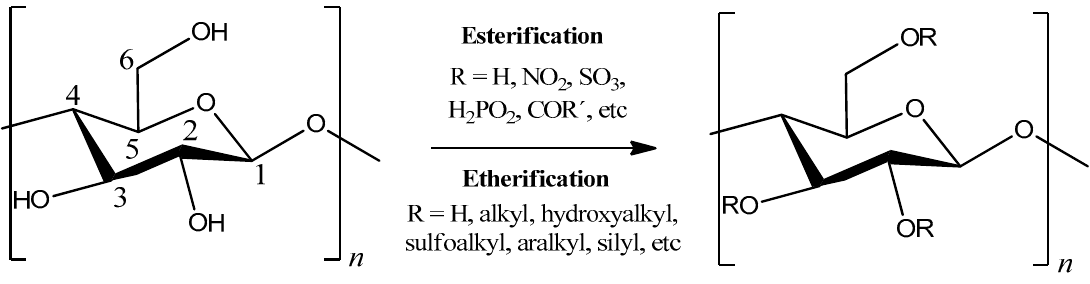
Figure 3. Synthesis of cellulose esters and ethers. Reprinted with permission from [135]. Copyright 2013 John Wiley and Sons.